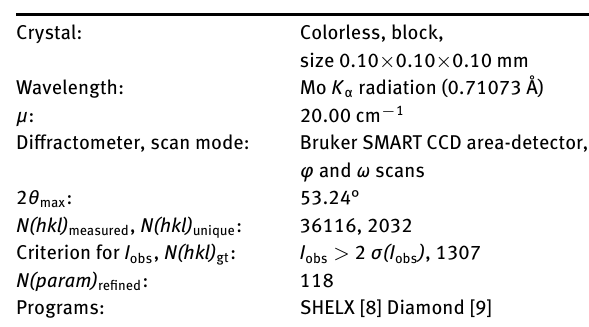
Table 1: Data collection and handling.